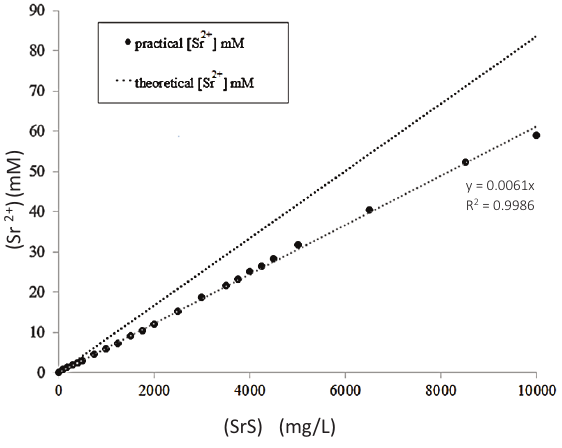
Fig. 3. Calculated and measured (EDTA titration) values of [Sr 2+ ] ions in SrS aqueous solutions in the range of [SrS] 15−10 000 mg·Lˉ 1 (0.125−83.552 mM).